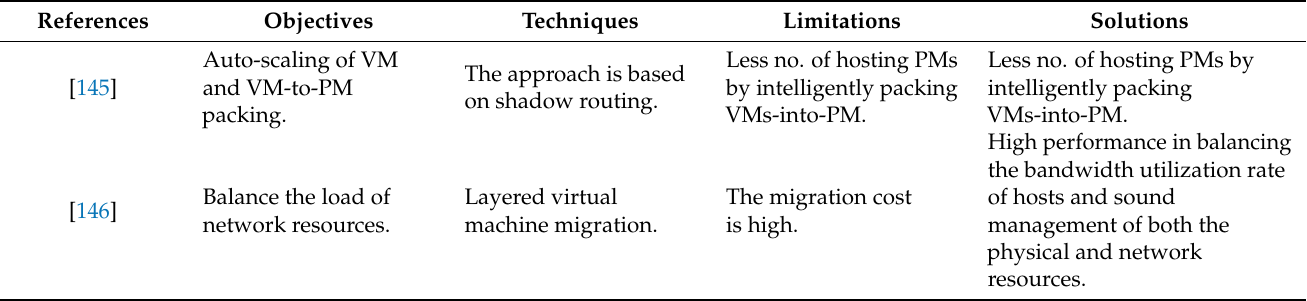
Table 7. The Cloud-Based Detection and